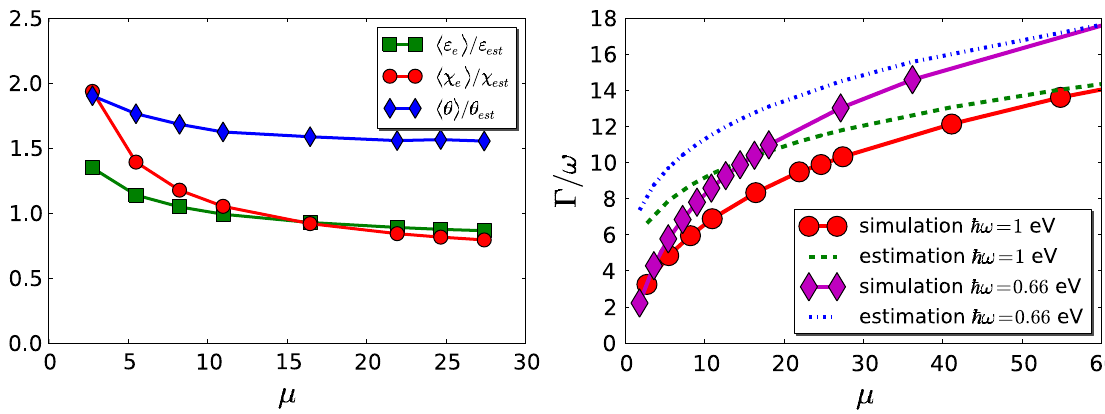
FIG. 7. Left plot: Parametric studies of the mean energy h " e i , the mean dynamical quantum parameter h (cid:5) e i , and the mean angle h (cid:2) i between the momentum and the field for electrons and positrons. The ratios of the simulation results to the approximations (12b) and (12c), are plotted vs the parameter (cid:6) for @ ! ¼ 1 eV . Right plot: Parametric study of the increment (cid:2) as a function of the dimensionless field strength (cid:6) for two rotation frequencies @ ! ¼ 1 eV and @ ! ¼ 0 : 66 eV . The approximation (13) is shown by the dashed